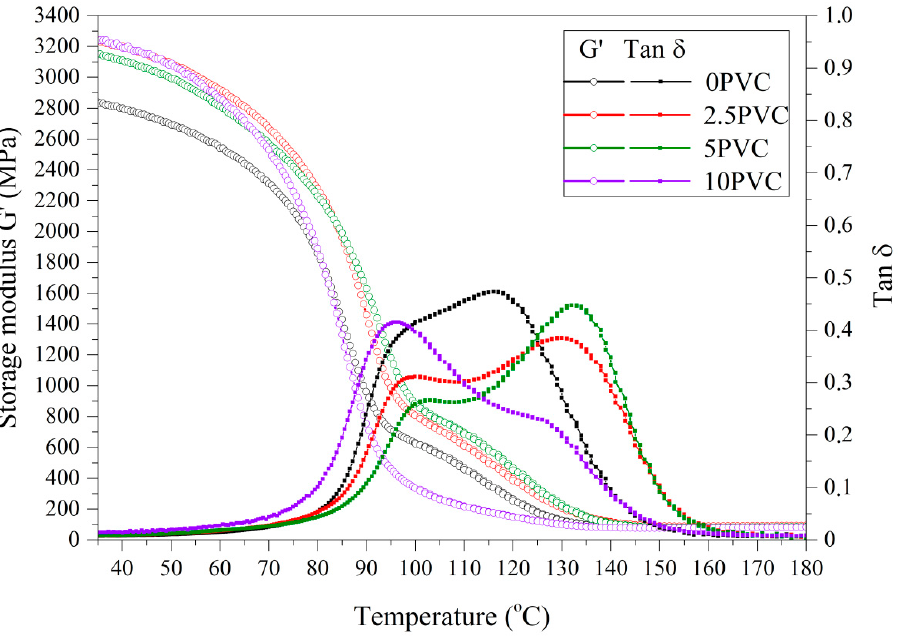
Table 1. DMTA analysis results.